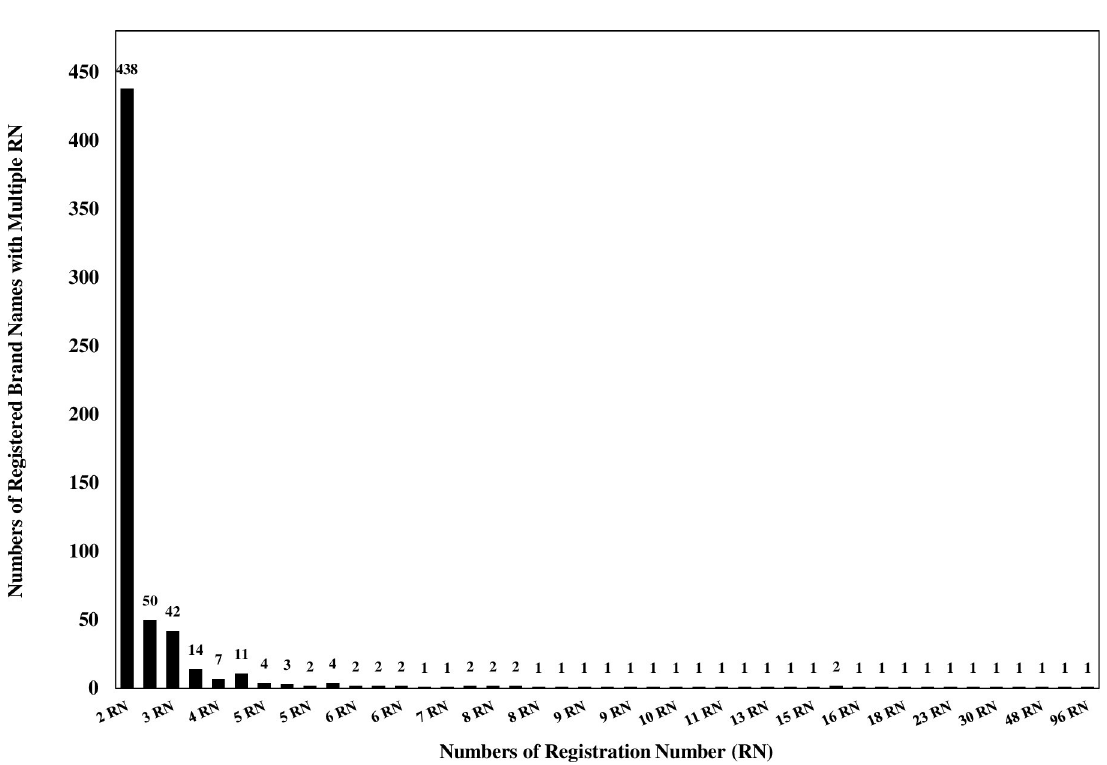
Fig 2. Analogy results of single brand names from different manufacturers having the same APIs and possessed several registration numbers.